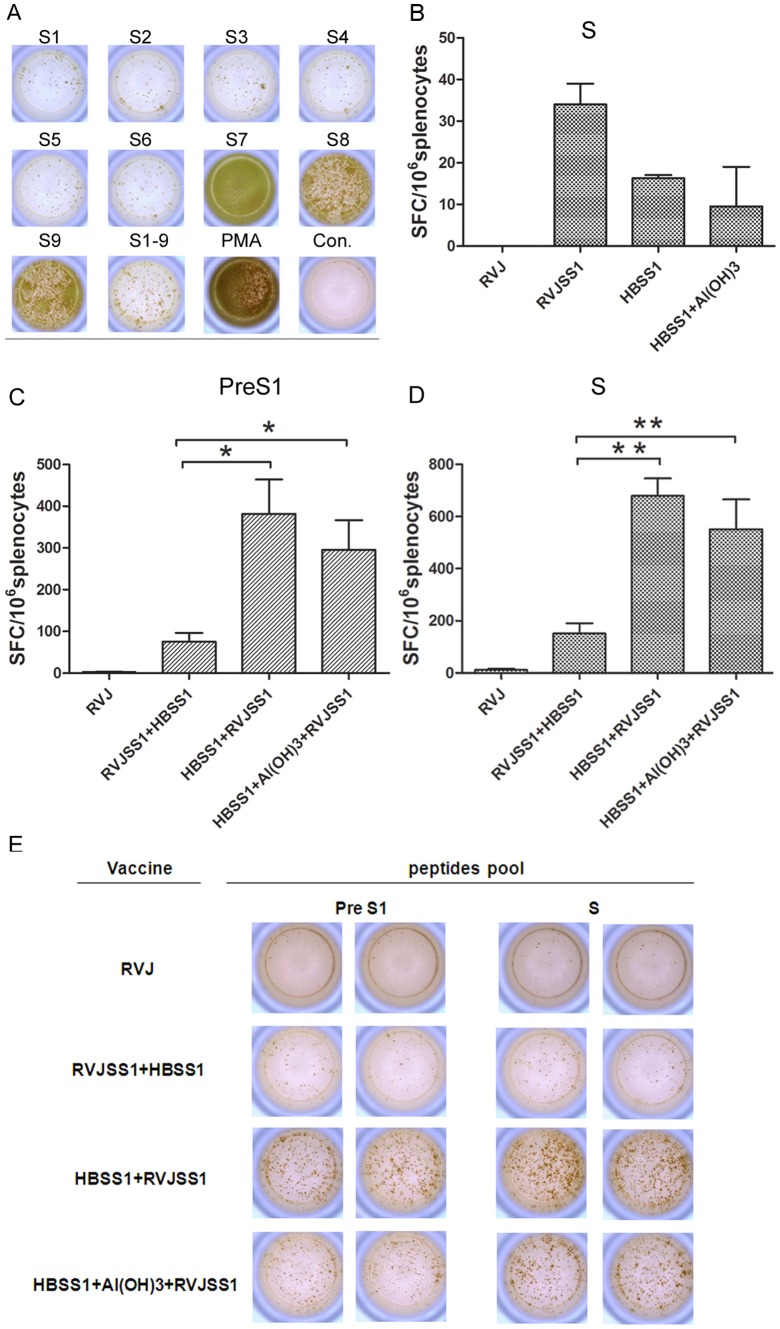
HBV S epitopes screening and ELISpot analysis of IFN-γ secretion in mouse splenocytes of each immunization group.(A) HBV S epitopes were screened by IFN-γ ELISpot analysis. Actual sample wells of HBS-specific ASC spots. (B–D) HBV peptide-specific ASC frequency in each group. Data represent the average of spot-forming cells (SFCs) per million splenocytes from six mice/group plus the standard error. B:Splenocytes were collected 10 days after the first immunization and the number of IFN-γ secreting cells generated in response to S peptides; C–D: Splenocytes were collected 2 weeks after the last immunization and the number of IFN-γ secreting cells generated in response to PreS1 and S peptide pool stimuli respectively. Statistical differences between groups were determined, and differences are shown as *p<0.05 and **p<0.01. (E) Sample wells with spots with mock or HBV peptide stimulation.